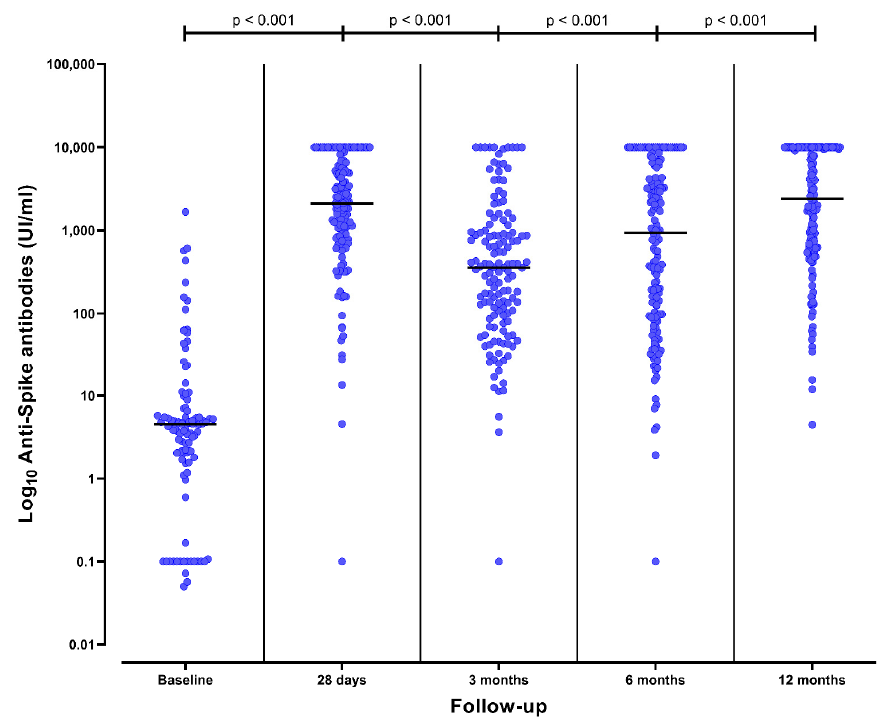
Figure 2. Anti-spike antibody titers over time from baseline (prior to SARS-CoV-2 vaccination) to 12 months after completing the initial vaccine schedule (i.e., 2 doses of mRNA vaccine) in CKD patients on peritoneal dialysis. The black line represents the median value of each strata.